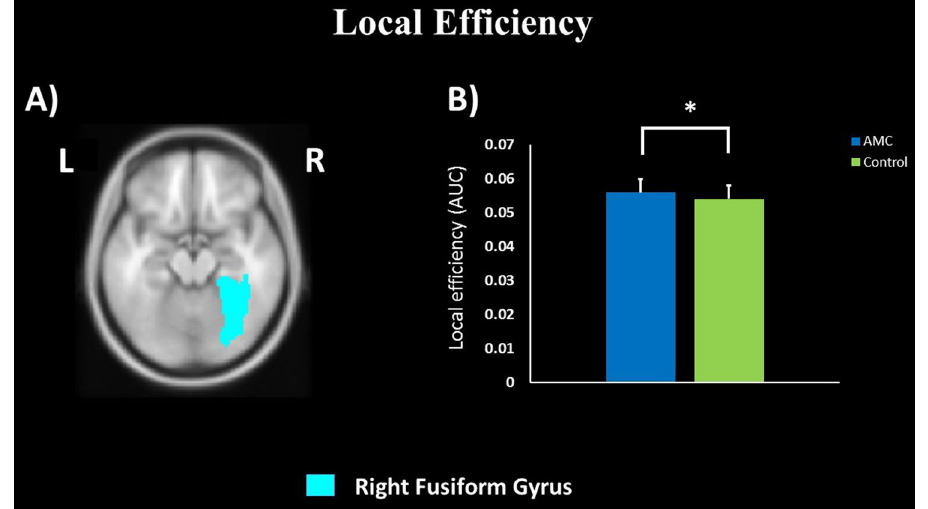
Figure 1. Group differences in nodal local efficiency in right fusiform gyrus. * p corrected < 0.05. L: left, R: